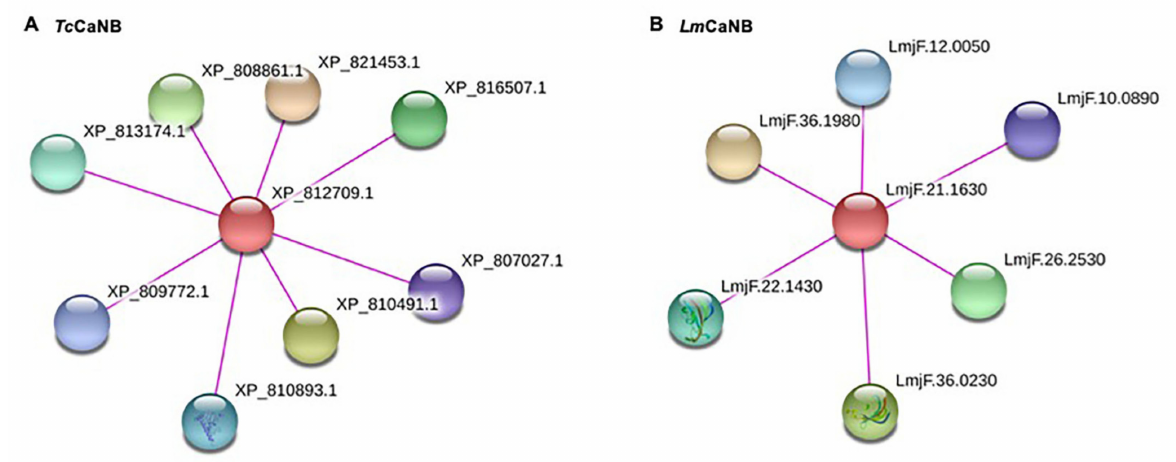
Figure 9. Protein–protein interaction network of the Tc CaNB ( A ) and Lm CaNB ( B ) proteins (STRING V.11.0). The line color indicates the type of interaction evidence (experimentally determined). Parameters: score (high confidence 0.7), sources of interaction used: experimental and databases. In A: XP_812709.1 (calcineurin B subunit, putative), XP_810491.1 (serine/threonine-protein phosphatase), XP_821453.1 (serine/threonine-protein phosphatase), XP_816507.1 (peptidylprolyl isomerase), XP_813174.1 (peptidylprolyl isomerase), XP_810893.1 (peptidylprolyl isomerase), XP_809772.1 (peptidylprolyl isomerase), and XP_807027.1 (peptidylprolyl isomerase); and in B: LmjF.36.1980 (serine/threonine protein phosphatase 2B catalytic subunit A2), LmjF.36.0230 (peptidyl-prolyl cis-trans isomerase, putative), LmjF.26.2530 (serine/threonine protein phosphatase, putative), LmjF.22.1430 (peptidylprolyl isomerase; Fk506-binding protein 1-like protein), LmjF.12.0050 (hypothetical protein, conserved), and LmjF.10.0890 (FKBP-type peptidyl-prolyl cis-trans isomerase).